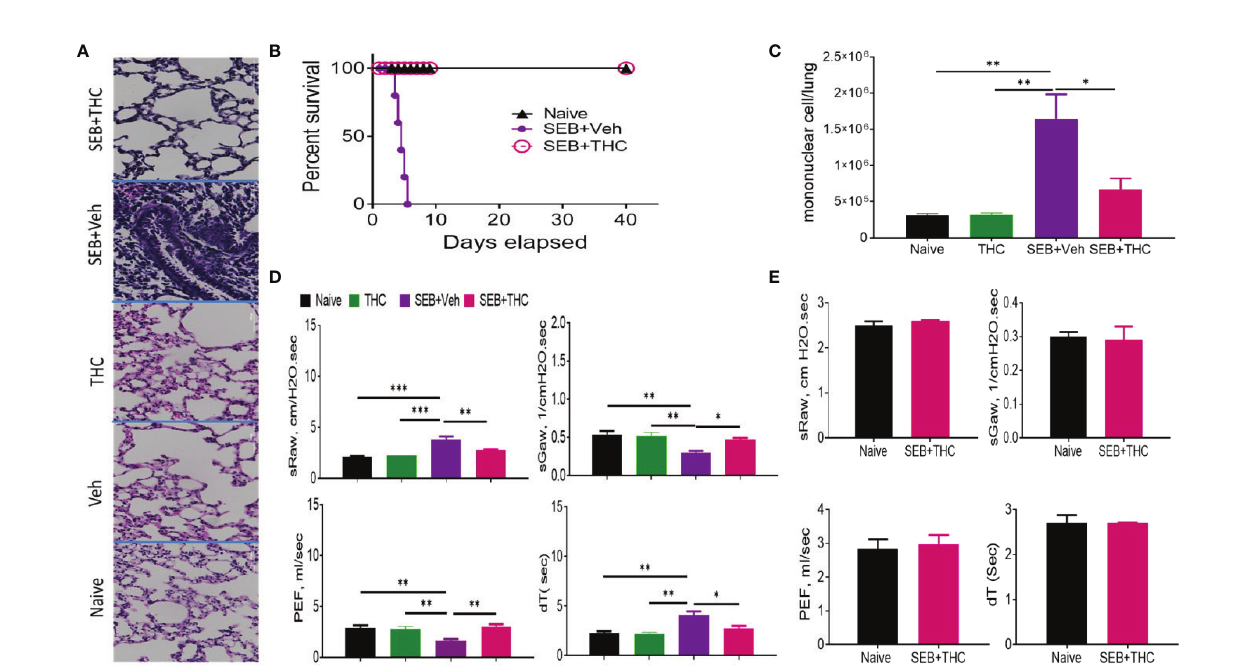
FIGURE 1 | THC attenuates SEB-induced ARDS in mice. SEB was administered fi rst by the intranasal (i.n.) route followed by a second dose of SEB was delivered (i.p.) as described in Methods. Mice were then treated with vehicle (SEB + Veh) or THC (SEB + THC). (A) Representative images of histopathological H and E staining sections of excised lung tissues from naïve, Veh, THC, SEB + Veh, and SEB + THC (B) Showing survival of mice 40 days post lethal dual-dose exposure to SEB and treated with THC or Vehicle and naive group. (C) Total number of MNCs isolated from the lungs. (D) Pulmonary performance (sRaw, speci fi c resistance airway; sGaw, speci fi c conductance airway; PEF, peak of expiratory fl ow; dT, delayed time of translocation of air from thoracic to nasal canal and verse versa). (E) Evaluation of mice by Whole-body non-invasive plethysmograph Buxco 72 h post-SEB-induced ALI. Pulmonary performance as shown in panel (D) , was evaluated in mice that survived after SEB + THC for 40 days when compared to naïve mice. In all these experiments, groups of fi ve mice were used and data con fi rmed in three independents experiments. Statistical signi fi cance is depicted as *p < 0.05, **p < 0.01, ***p < 0.001 between the